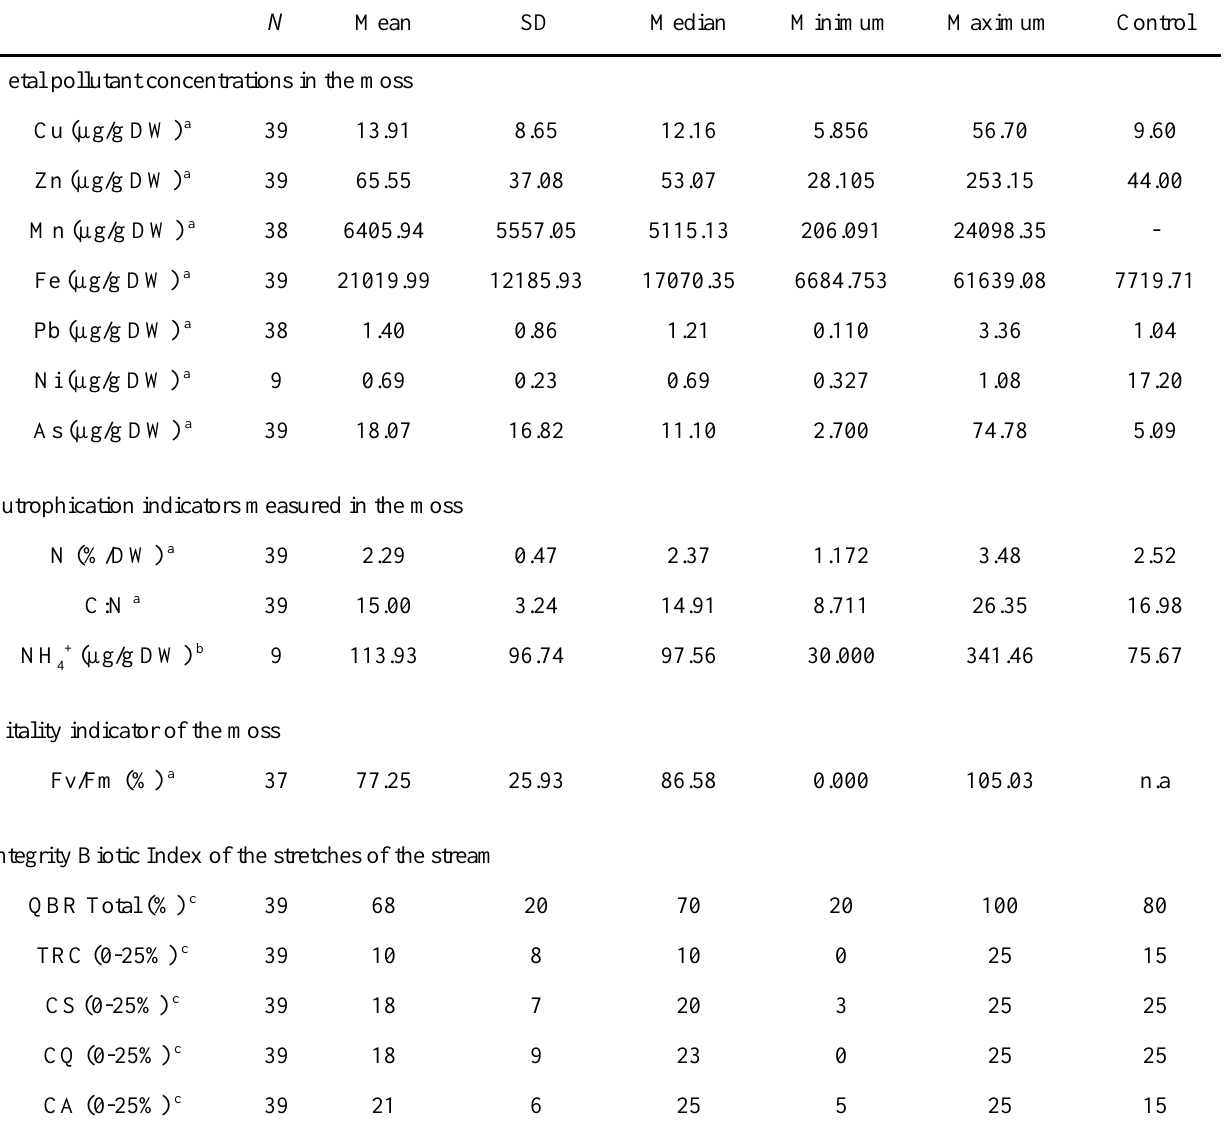
a average values for the time period from September 2004 to June 2005. b values assessed from March to June 2005. c values assessed from March to June